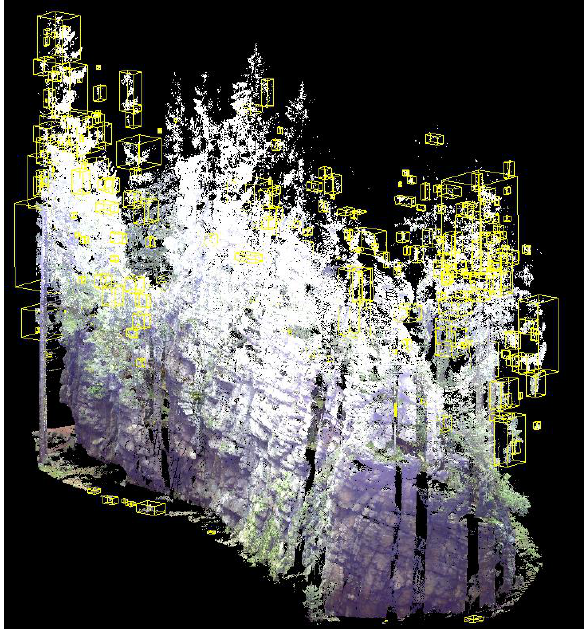
Figure 6. Selection of clusters of points belonging to a separate part of the branches and treetops executed in the program CloudCompare ver.